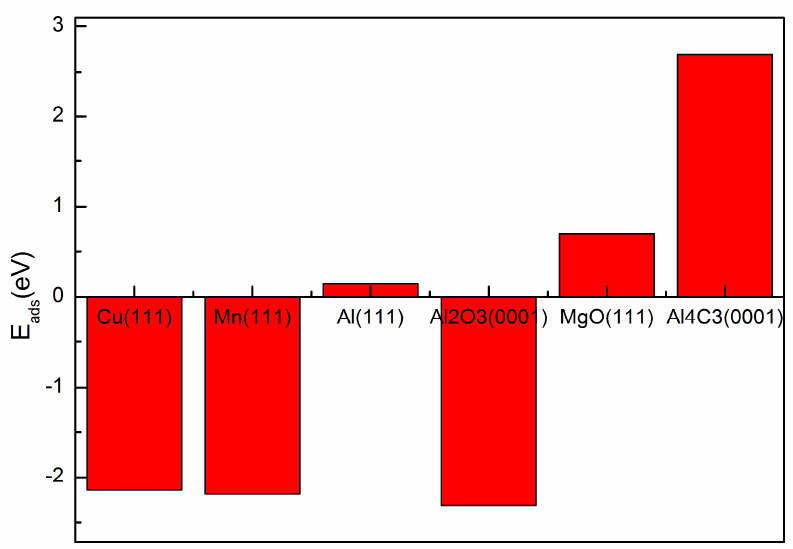
Figure 3. Average adsorption energy of H on Cu(111), Mn(111), Al(111), Al 2 O 3 (0001), MgO(111) and Al 4 C 3 (0001).